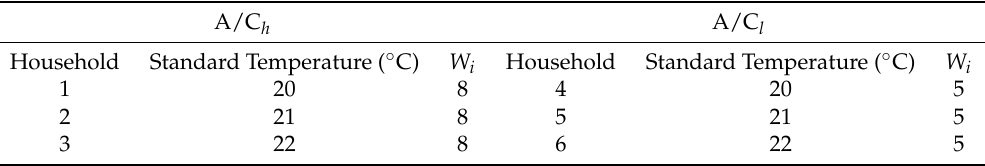
Table 2. A/C (air conditioning) parameters of